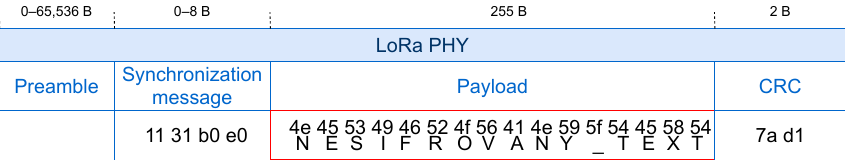
Figure 10. Decoding of the captured LoRa packet.